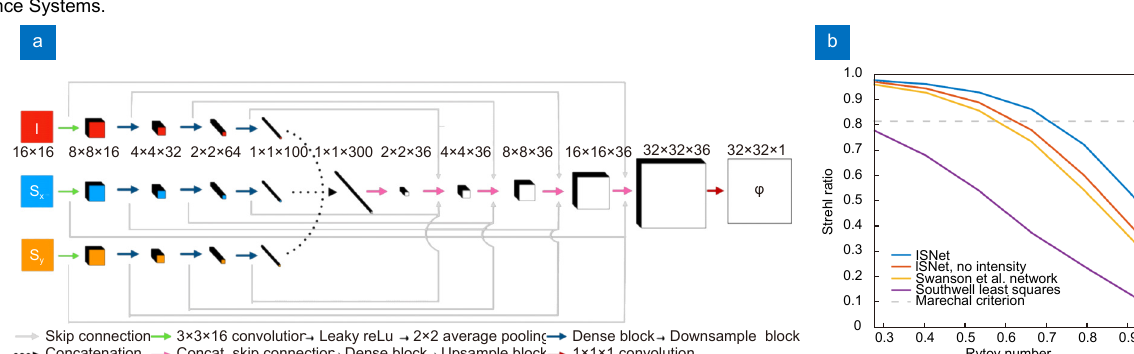
Fig. 6 | ( a ) Architecture of ISNet. This network takes three 16×16 inputs ( x -slopes, y -slopes and intensities) and outputs a 32×32 unwrapped wavefront. ( b ) Plot of average Strehl ratio vs. Rytov number for different reconstruction algorithms. For comparison, the Strehl ratio of a Marèchal criterion-limited beam is shown in (b), which is 0.82. Figure reproduced from: (a, b) ref. 75 , Optical Society of